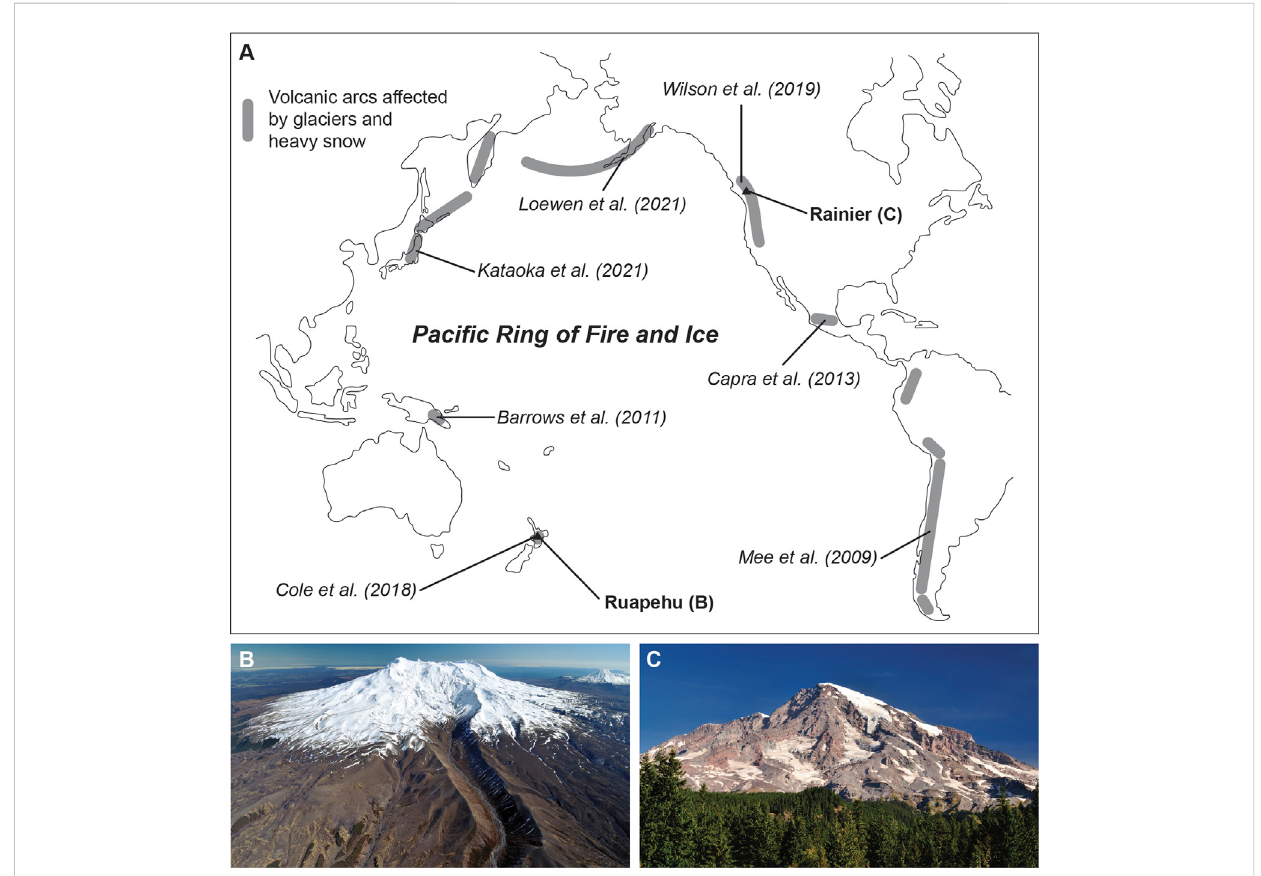
FIGURE 1 Locations and examples of arc stratovolcanoes where glaciovolcanism has occurred during the last ~250,000 years. (A) Map of volcanic arcs (grey lines) around the Paci fi c Ocean that have been affected by glaciers and heavy snow. Locations are noted for Rainier and Ruapehu volcanoes, and for representative study sites mentioned in the text. (B) Photograph of a glacial valley (Wahianoa River) on the southeast fl ank of snow-covered Mount Ruapehu in New Zealand. (C) Photograph of the southeast fl ank of Mount Rainier in Washington, United States, which comprises glaciers and steep ridges of lava. Photographs were provided by Dougal